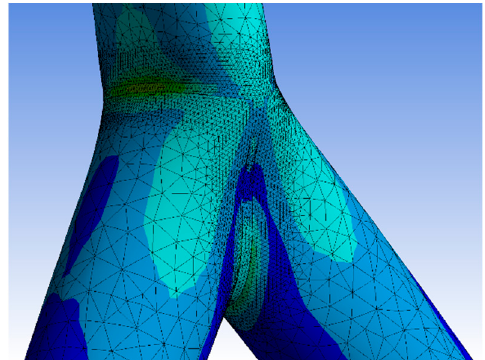
Figure 10. Von-Mises stress distribution and deformation.